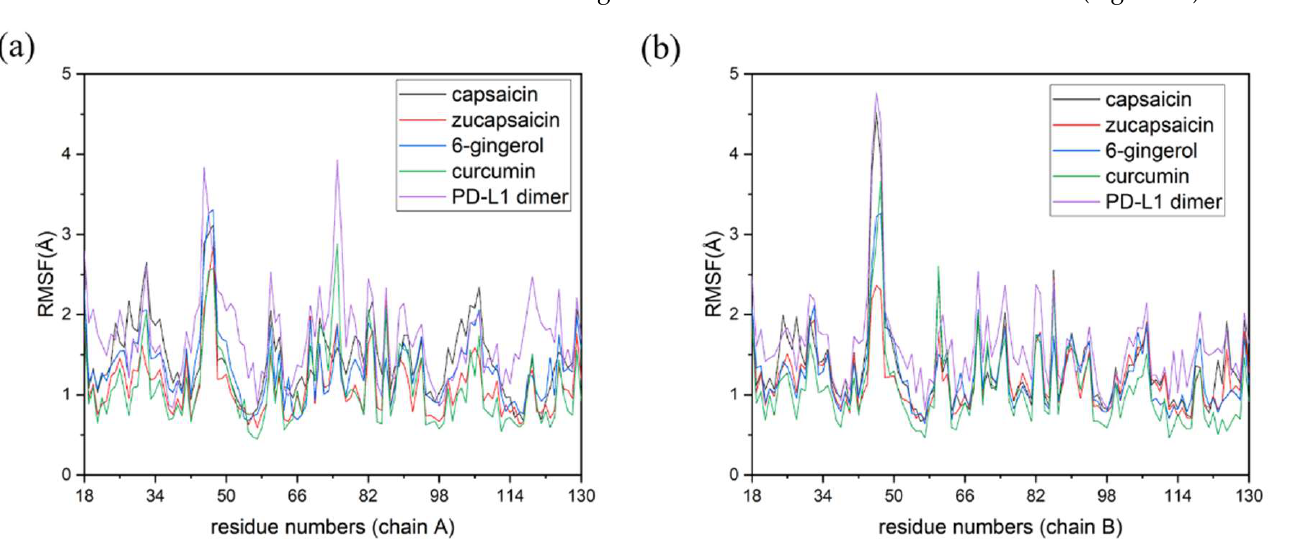
Table 1. The binding free energy values of capsaicin, zucapsaicin, 6-gingerol and cur- cumin to the PD-L1 dimer are − 42.53 kcal/mol, − 43.75 kcal/mol, − 39.20 kcal/mol and − 39.19 kcal/mol,